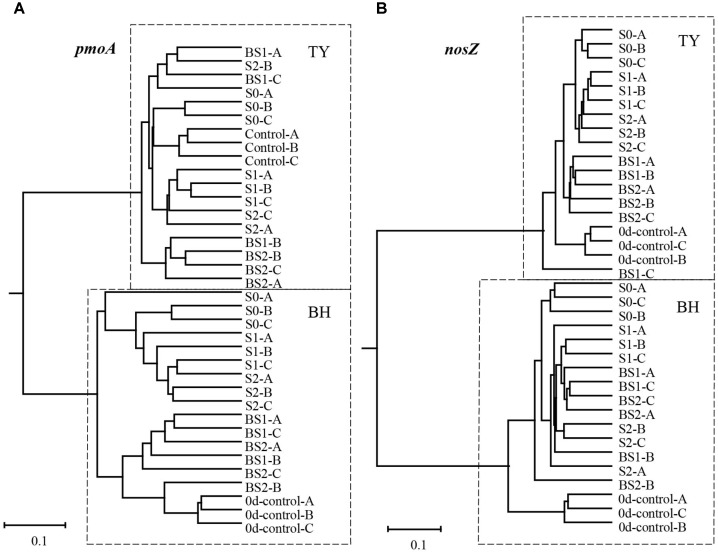
UPGMA dendrogram contrasted from Bray–Curtis distance matrix of pmoA
(A) and nosZ I (B) gene sequences at day 18 during the seedling stage. 0d-control represents the background of original soil at the beginning of pot experiment, and A, B, C mean three replicate pots.